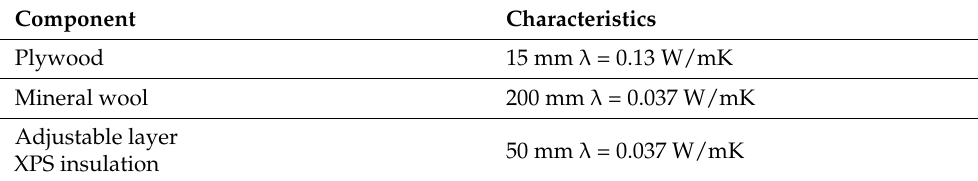
Table 3. Components of the small scale PASLINK test cell.